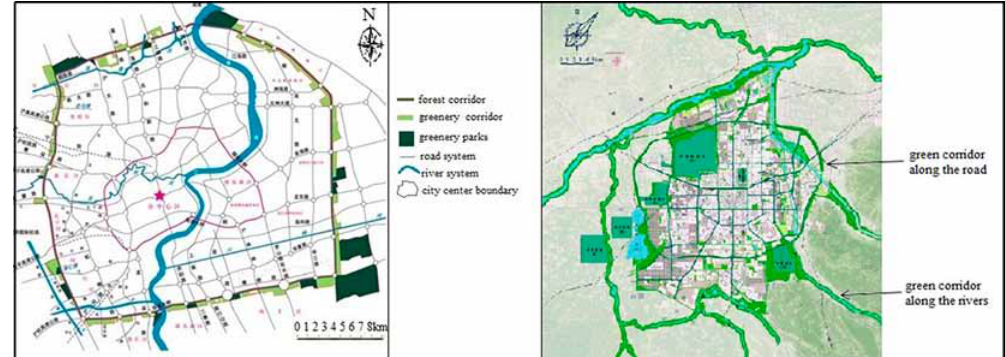
fig. 2. Greenbelt plans of Shanghai (left) and Xi’an (right). Based on the road system, the Shanghai Greenbelt Plan was categorized into two main belts. The first is the forest belt, 100 meters wide with trees to build a stable environment for ecological communities, and the second is the greenery belt, 400 meters wide with productive nurseries, memorial landscape and agricultural fields. another notable point in the Shanghai Greenbelt Plan is that parks are designed as connectors of different greenbelt areas served for recreational function (Shanghai City belt Institution of Construction and Management and Xi’an urban Planning and Design